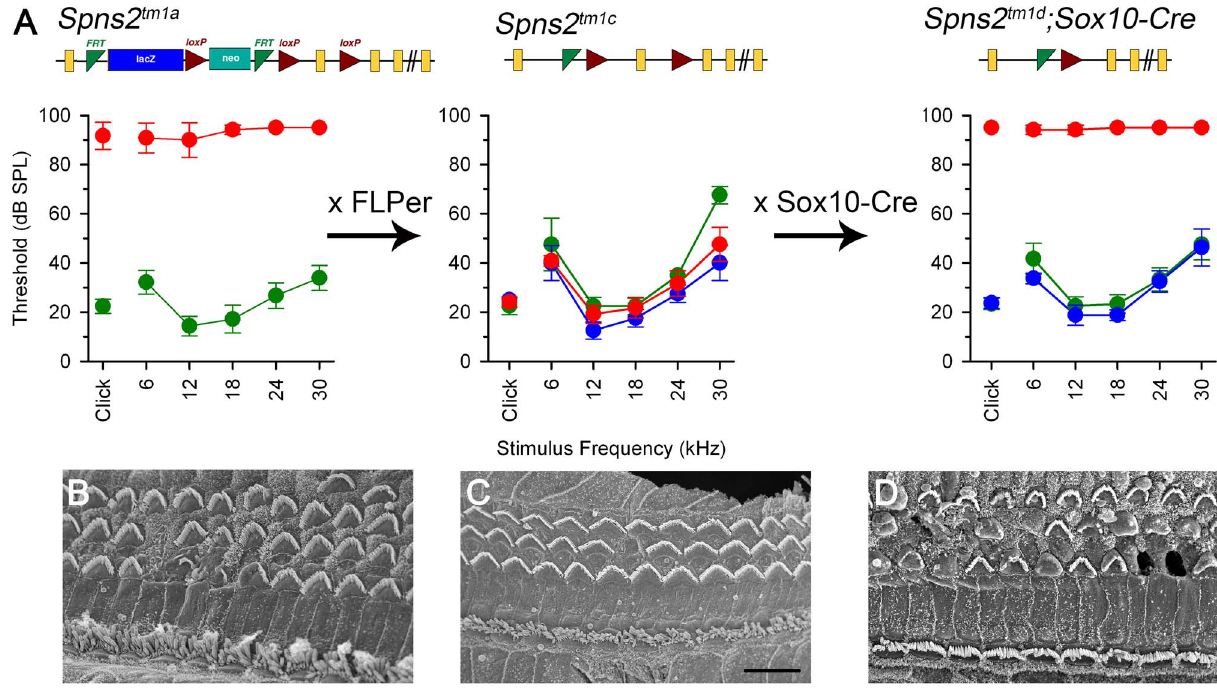
Figure 9. ABR thresholds and SEM assessment suggest a local function of Spns2 in the inner ear. ABR thresholds (means + / 2 SD) are shown for homozygotes (red), heterozygotes (blue) and wildtypes (green), aged 7–14 weeks. Mice homozygous for the Spns2 tm1a allele displayed elevated ABR thresholds and degeneration of hair cells ( A left , 4 wks and B ). By crossing with mice expressing Flp recombinase to excise the inserted cassette, Spns2 tm1c/tm1c mice were produced, which had normal ABR thresholds and normal hair cell morphology ( A middle , 8 wks and C ). Then Spns2 tm1c/tm1c were crossed with Sox10-Cre mice to produce Spns2 tm1d/tm1d ;Sox10-Cre mice which showed no response up to 95 dB SPL and hair cell degeneration with bulges and holes in the reticular lamina ( A right , 4 wks and D ). SEM images are taken from the middle turn (40–70%) of the cochlea. Scale bar: 10 m m in B,C,D .